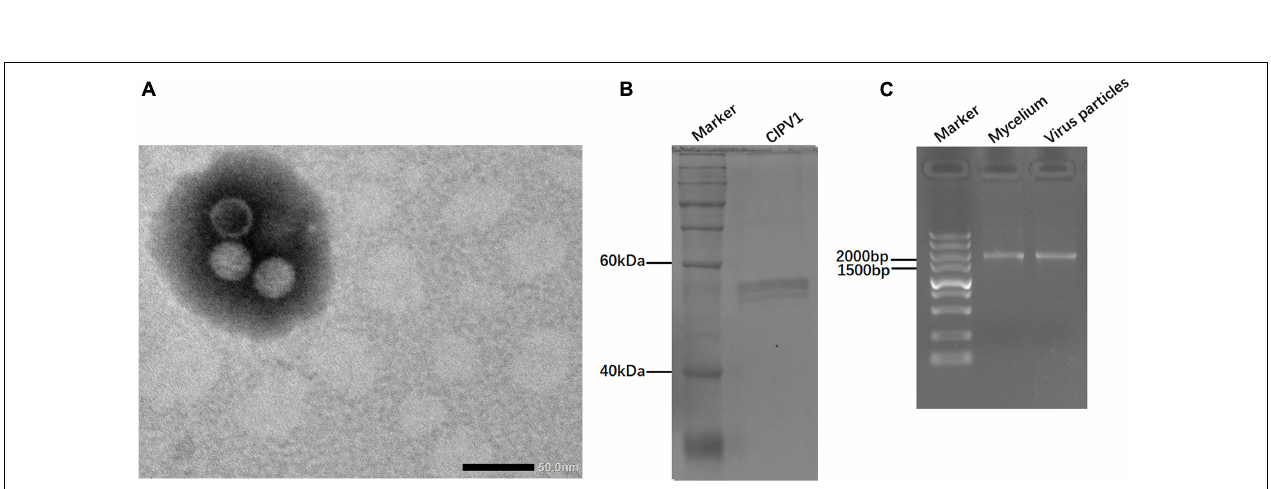
FIGURE 5 | Virus particles isolated from the mycelia of C. liriopes strain Cl-B-2. (A) Isometric, non-enveloped viral particles with diameter of 35 nm were observed by transmission electron microscope (TEM). (B) SDS-PAGE electrophoresis (12%) analysis of the purified virus particles showing the protein band of coat protein. (C) Agarose gel electrophoresis of dsRNA extracted from the mycelia and viral particles, respectively.